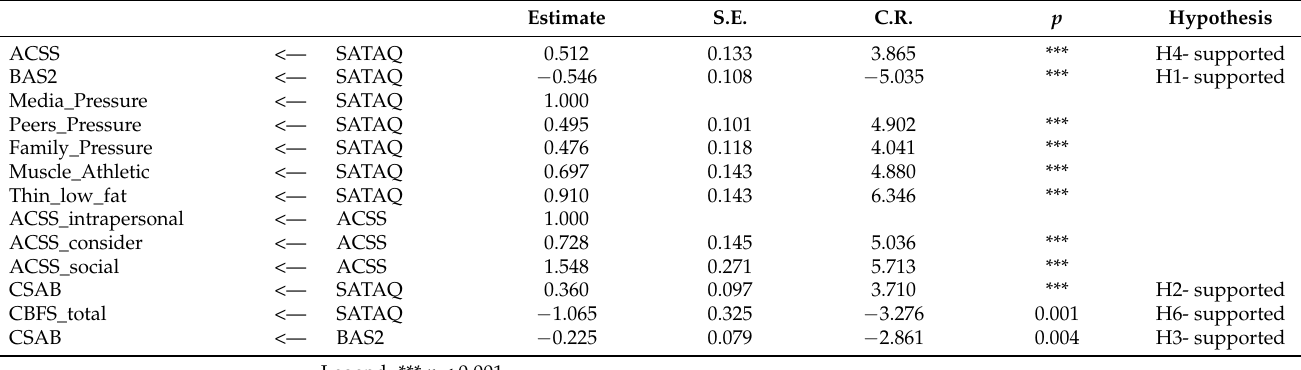
Table 7. SEM generalized least squares estimates of regression weights.